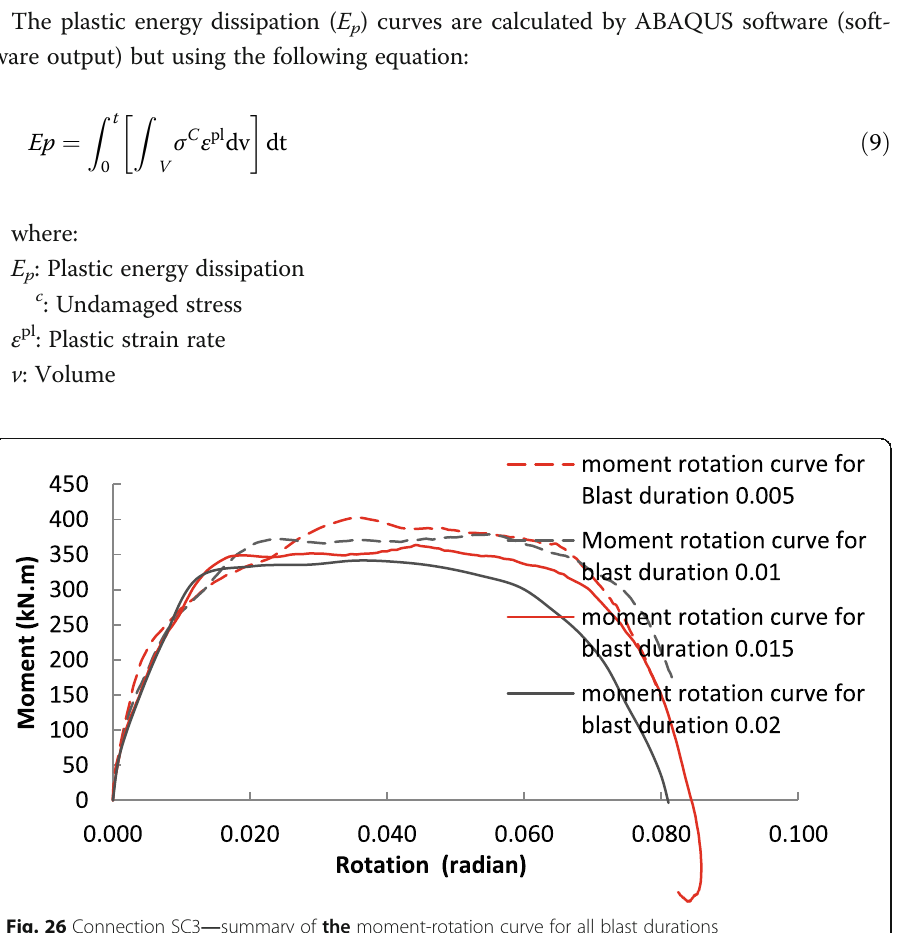
Fig. 26 Connection SC3 — summary of the moment-rotation curve for all blast